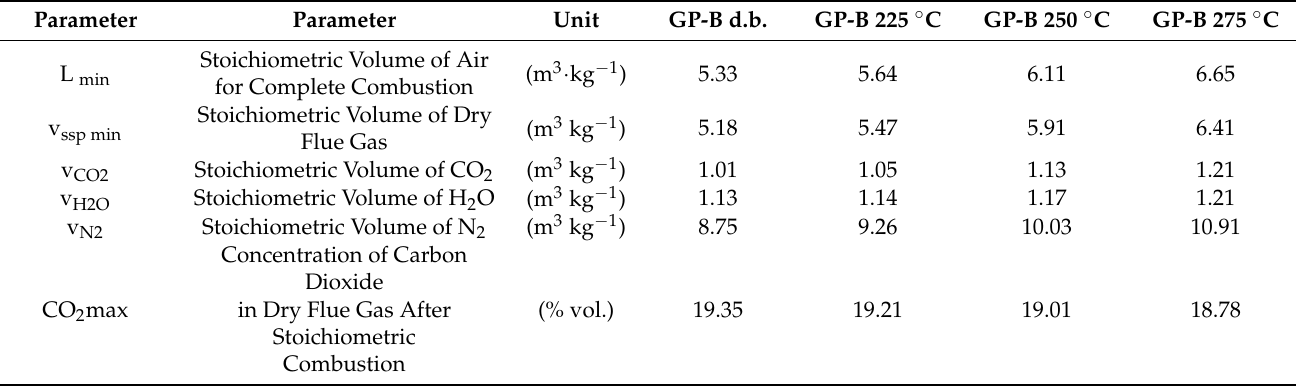
Table 4. Stoichiometric amount of air and specific productions of flue gas components from combustion grape pomace from blue grapevine (GP-B); d.b., dry basis.